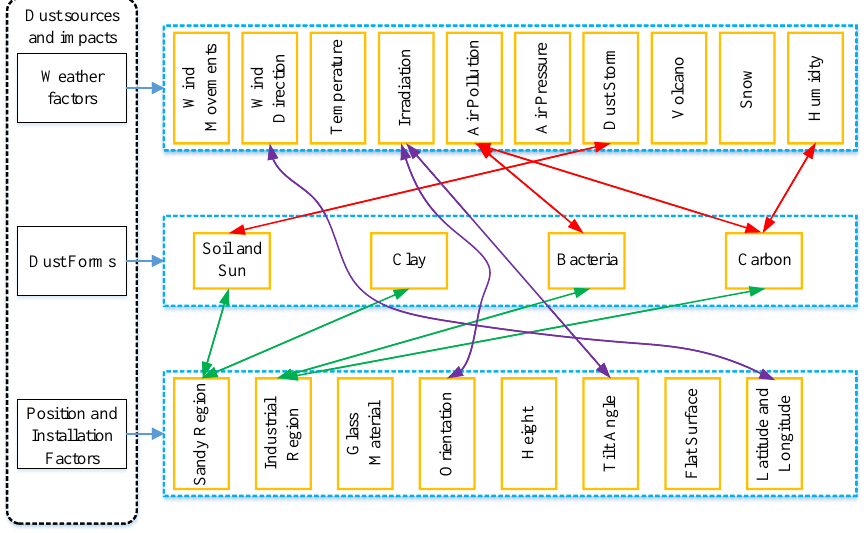
Figure 7. Causes of dust accumulation on the surface of PV arrays [83].